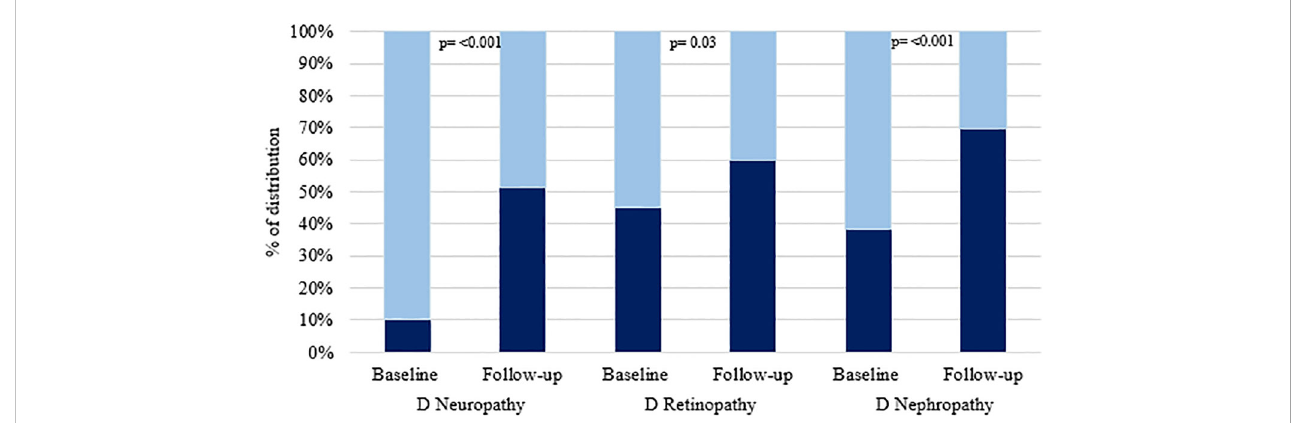
examined for their association with diabetic microvascular complications using an adjusted binary logistic regression model, serum levels of VCAM-1 [(diabetic neuropathy (OR=0.999, 95% CI=0.997-1.0, p=0.01); diabetic retinopathy (OR=0.999, 95%